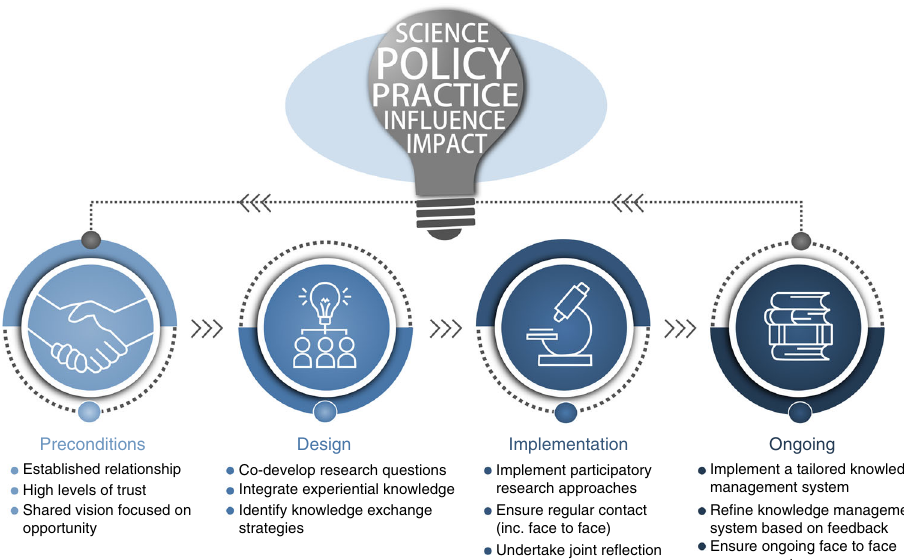
Fig. 1 Key principles underpinning success across science – policy – practice bright spots. These guidelines are based on the experiences of the two bright spots described in Table 1 (Shy Albatross and Southern Blue fi n